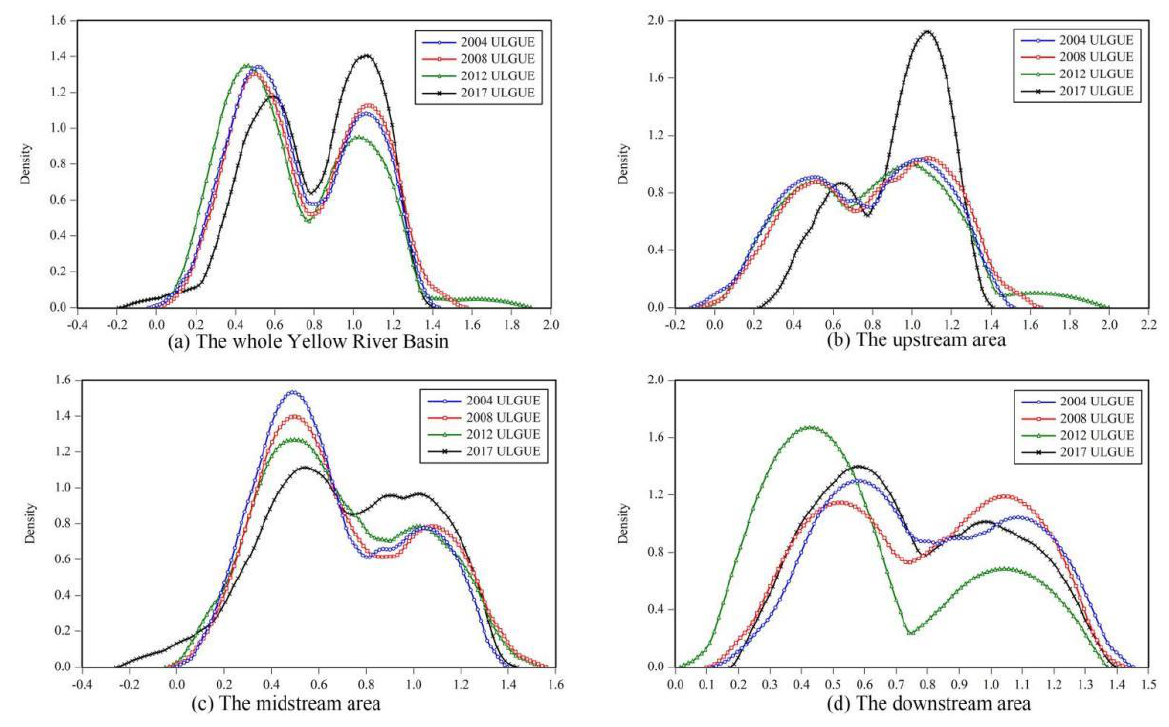
Figure 5. Evolution tendency of ULGUE in the YRB. ( a ) the whole YRB; ( b ) the upstream area; ( c ) the midstream area; ( d ) the downstream area.